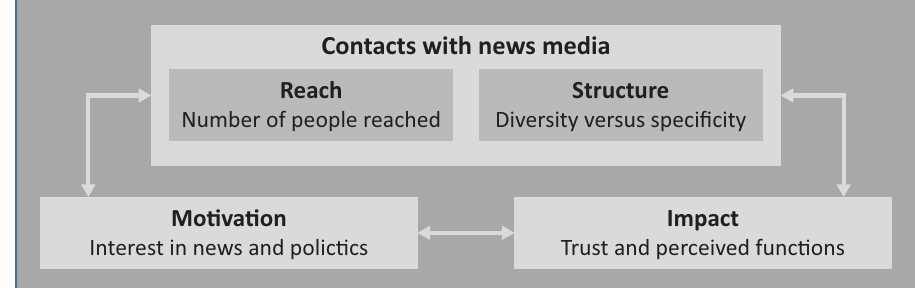
Figure 1. Conceptual framework for audience-based indicators of news media